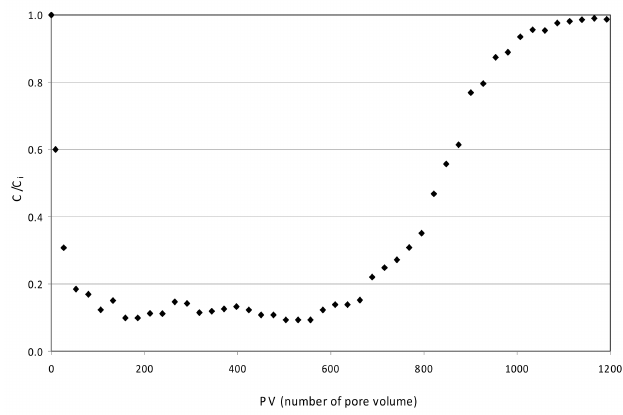
Figure 21. Normalized Pb 2+ concentration in the effluent (C/C i ) vs. number of exchanged pore volumes (PV) of